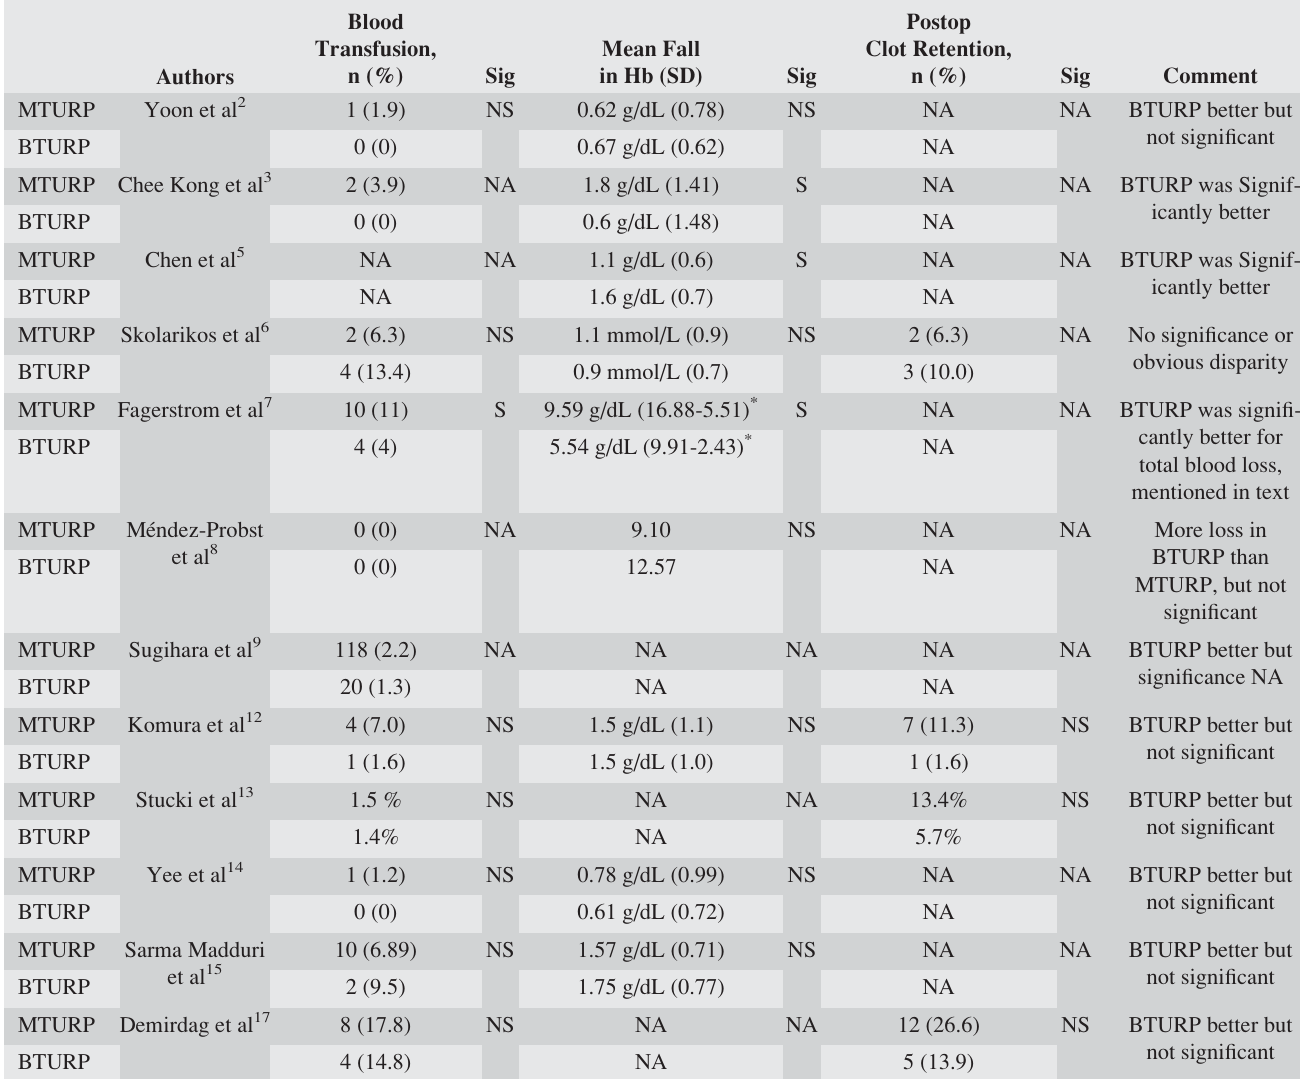
Table 4. Data From Papers Regarding the Need for Blood Transfusion, Drop in Hemoglobin (Hb) and Postoperative Clot